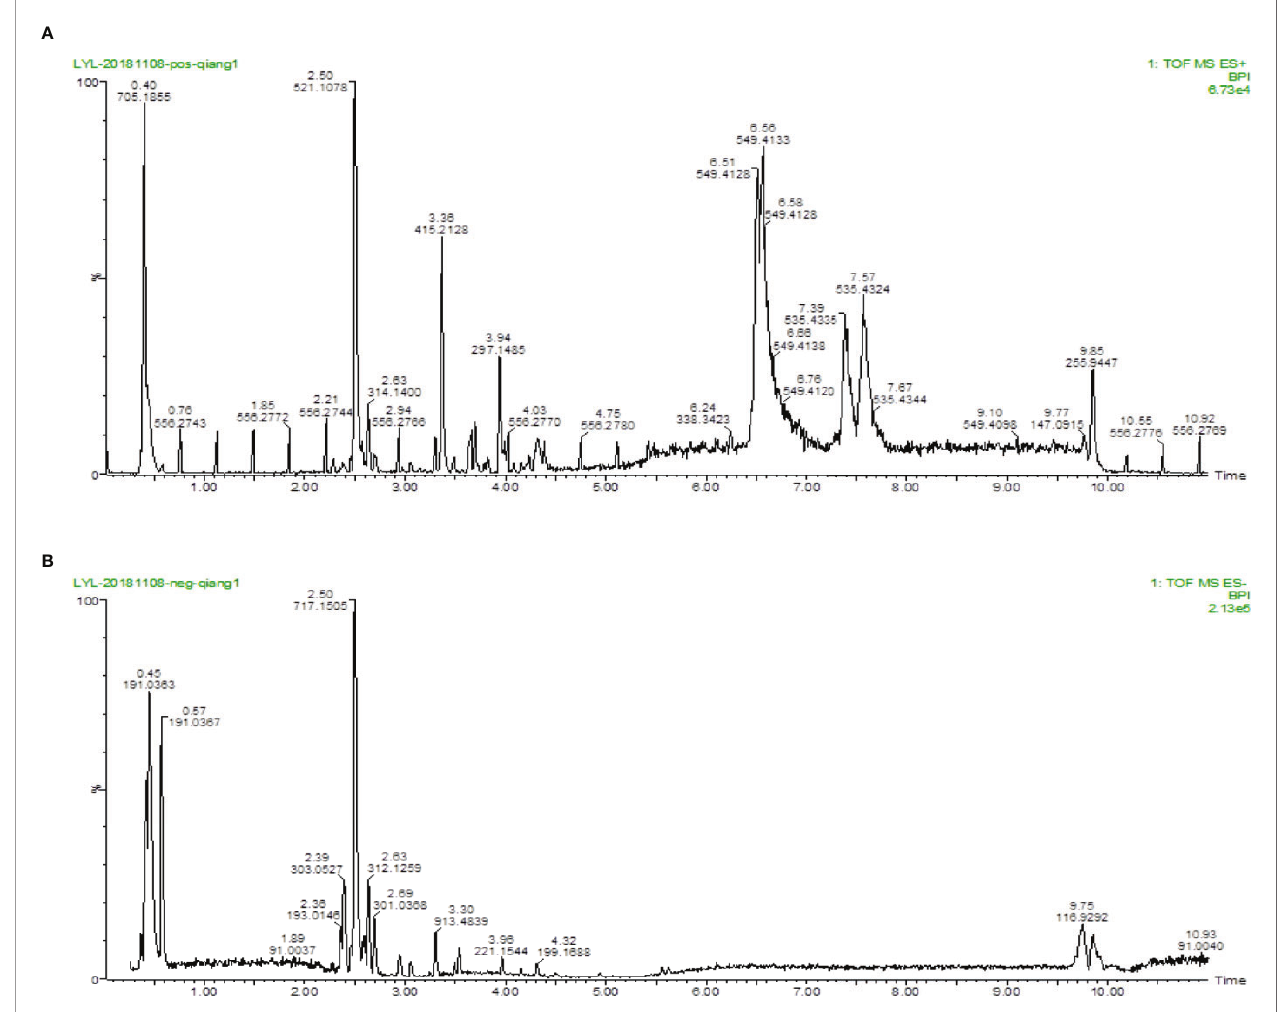
FIGURE 1 | Identi fi cation of major components of QX1 formula. QX1 formula sample were examined using UPLC – MS/MS. Base peak intensity chromatogram in the positive (A) and negative (B) ion modes for QX1 formula were shown as indicated. UPLC – MS/MS, Ultra Performance Liquid Chromatography-Tandem Mass